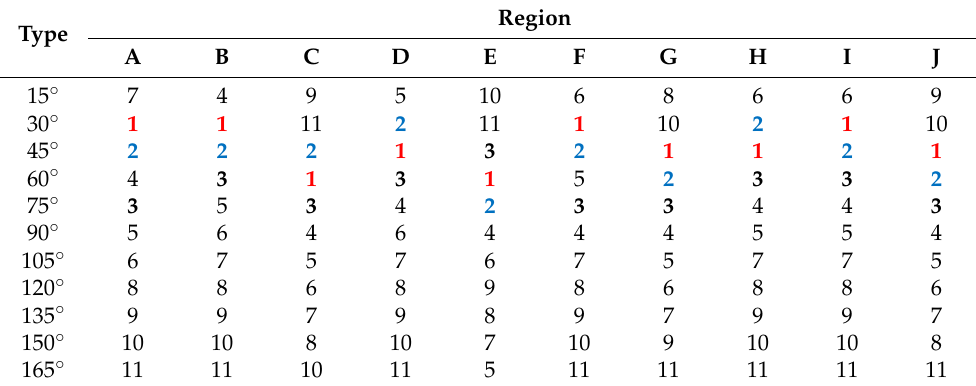
Table 11. Ranks of optimized installation angles for a kinetic louver in